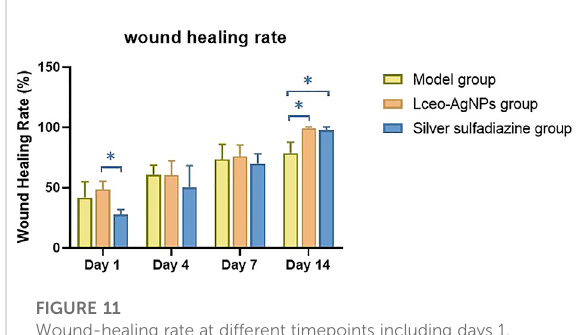
FIGURE 11 Wound-healing rate at different timepoints including days 1, 4, 7, and 14 after different treatments (* p < 0.05).